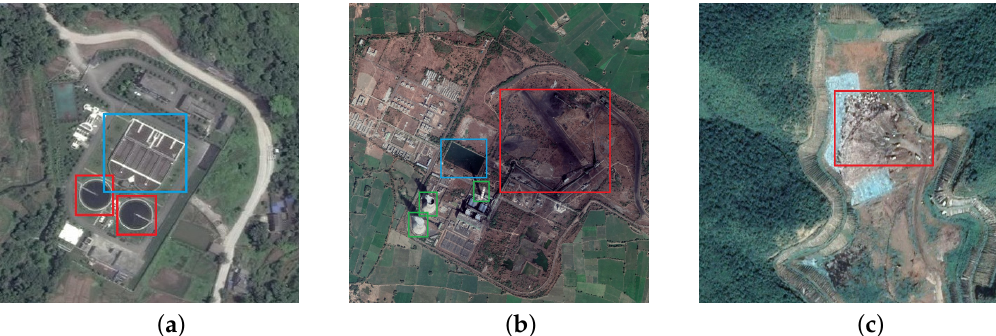
Figure 1. Facility objects which composed of several separate components. ( a ) sewage treatment plants including sed- imentation tanks (red bounding boxes) and arcuation sedimentation tanks (blue bounding boxes); ( b ) thermal power plants, including chimneys (green bounding boxes), coal yards (red bounding boxes) and pools (blue bounding boxes); ( c ) garbage dumps.